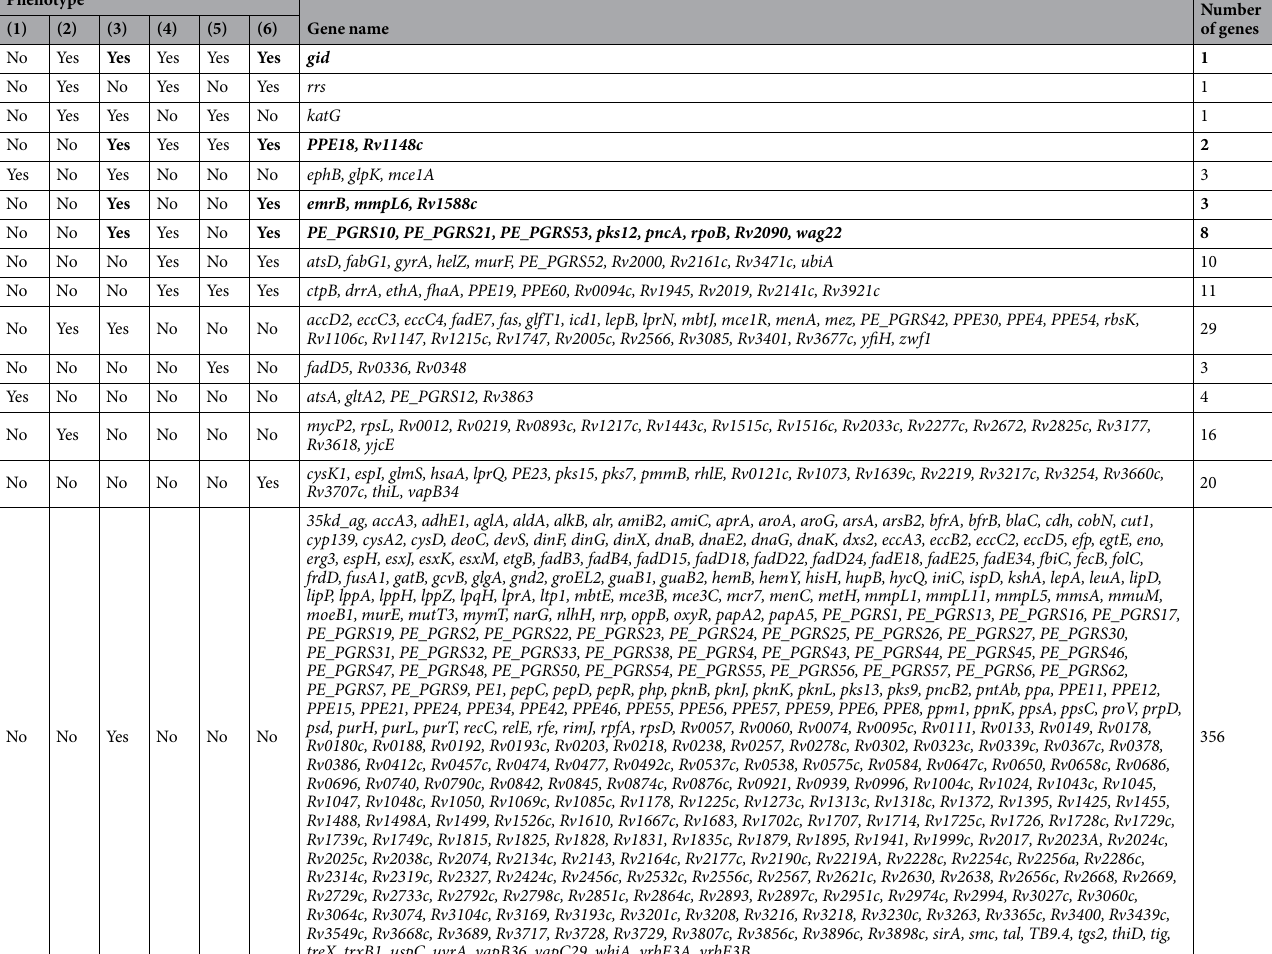
and one in pncA (the best q value in each gene was 4.856E-10, 7.943E-09, 7.943E-09, and 7.639E-12, respectively) (Supplementary Table S2). All k-mers annotated with PPE18 in both study sets were mapped to either PPE18, 19 , or 60. Nucleotide sequences within these three PPE genes were hardly distinguishable from each other (Supplementary Fig. S4); BWA-MEM mapping or simple BLAST search to the reference could not specify the exact PPE gene that each 31-bp k-mer belonged to. Nevertheless, the analysis of de novo assembled contigs demonstrated that the Hanoi variant k-mers were derived from PPE18 and KwaZulu-Natal’s k-mers initially annotated with PPE18 were derived from PPE19 . Such a high degree of sequence similarity was also observed in significant unitigs identified in both study sets with the DBGWAS approach. Therefore, these k-mers and unitigs were designated as PPE18/19 in our study (Table 3). Individual variant analysis using a genome-wide approach. When mapping the aforementioned sig- nificant k-mers of Hanoi samples on the H37Rv genome, we identified variants corresponding to the significant k-mers. Next, we attempted to confirm the variants by SNV- and small indel-based GWAS or BLAST search, and finally identified mutations encoding E99A and A101T, in PPE18 , E173 * (Glu173Stop) in the gid , F508S in emrB ,